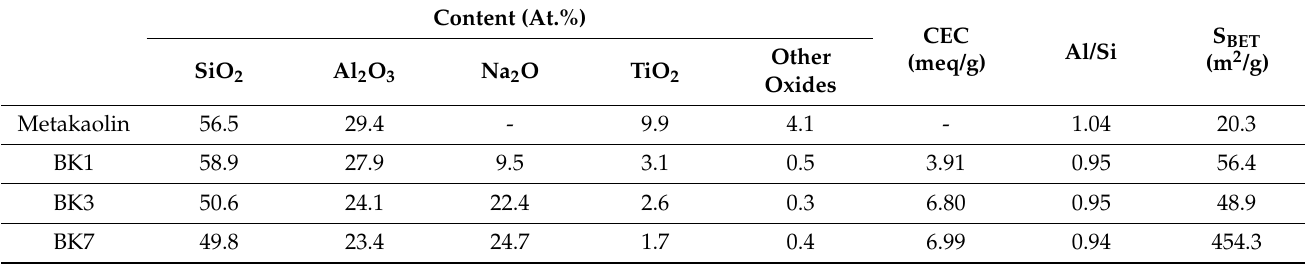
Table 1. Elemental composition and specific surface area (S BET ) of metakaolin and the alkali- activated